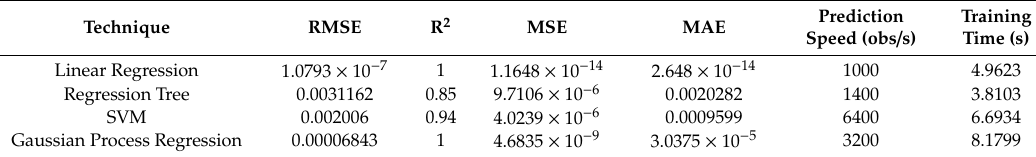
Table 5. Comparison of viscosity validation results with other